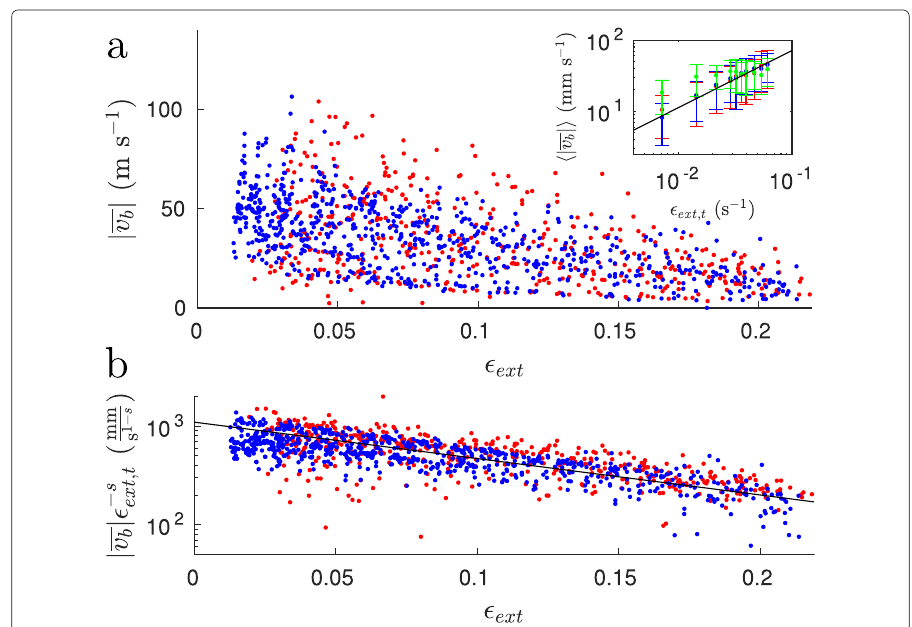
Fig. 3 a The behavior of mean band velocities with external strain in experiments (red) and simulations (blue). The Inset shows the mean band velocity from experiments (red) and simulations (blue) as a function of the strain rate and behavior of the simulations (green) with a constant D = 7 · 10 − 6 m 2 / s. The straight line is a power-law fit (cid:2) 0.8 ext , t . b The scaled velocities from experiments (red) and simulations (blue). The black line is an exponential fit exp ( − 8.5 · (cid:2) ext )